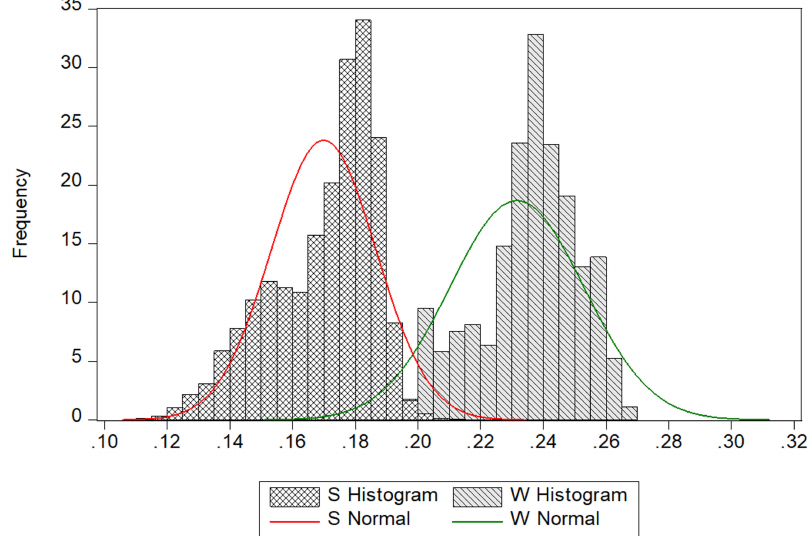
Figure 4. Frequency histogram of water (W) and shadow (S) in the normalized di ff erence water index